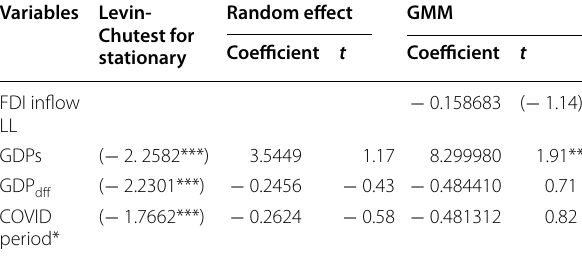
All variables are found to be 1(0) at 1% level